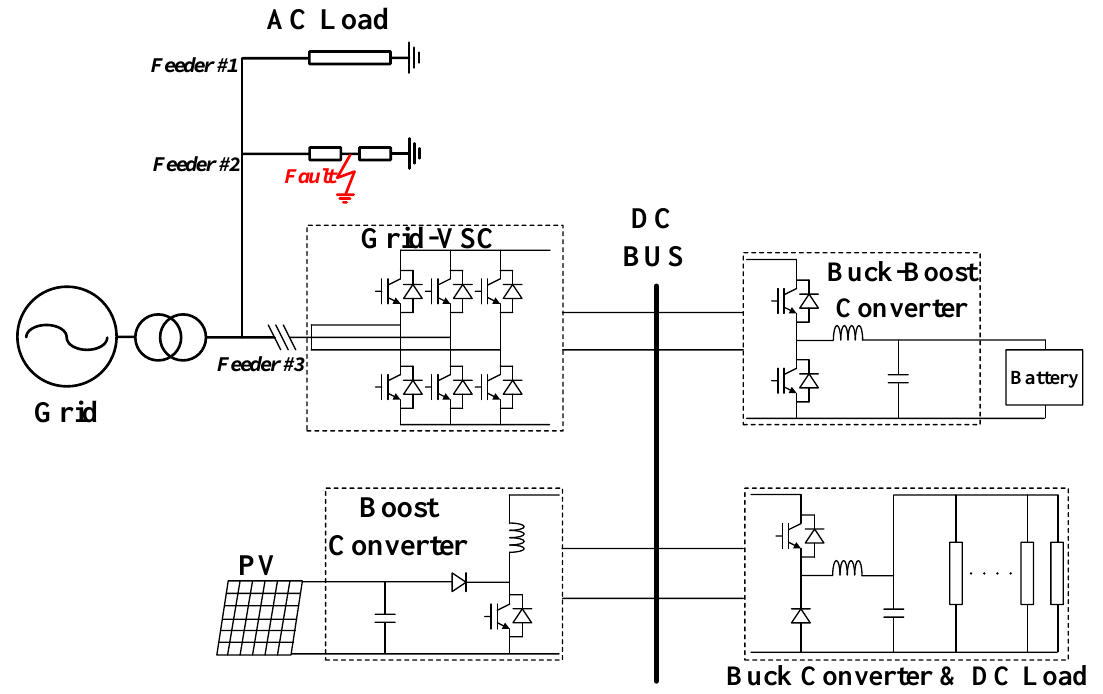
Figure 3. Configuration of AC/DC Power Distribution system with PV (photovoltaic), BESS (battery energy storage system) and DC Load connected to DC Link.